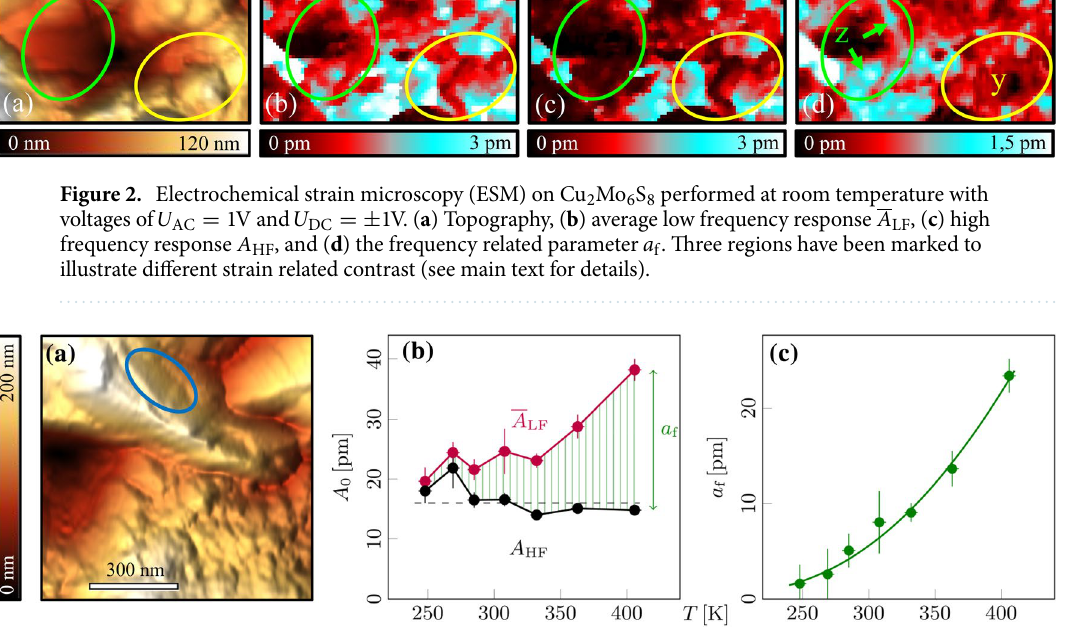
Figure 3. ( a ) Topography of the Cu 2 Mo 6 S 8 surface with an indication of the area under investigation in ( b , c ). ( b ) Linear plot of amplitudes A HF (black) and A LF (red) averaged over the outlined region. The HF amplitude is constant over the temperature range, while the average LF amplitude increases with temperature. ( c ) The parameter a f extracted from ( b ) increases exponentially with